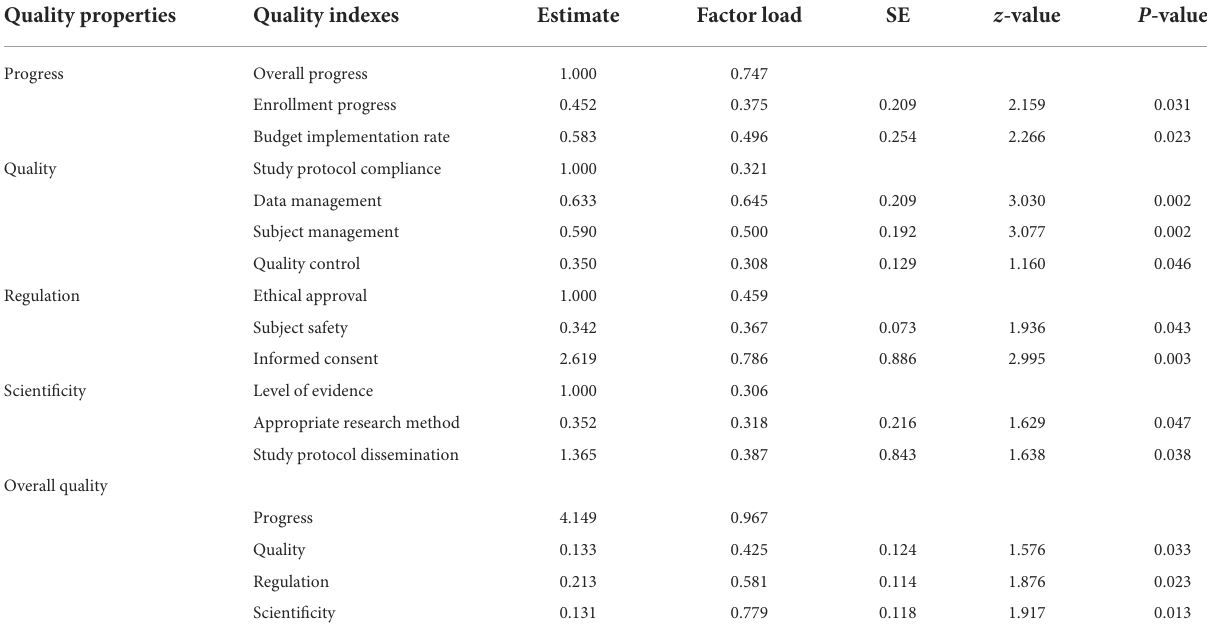
TABLE 4 Validation of quality assessment tool of investigator-initiated trials by CFA. Quality